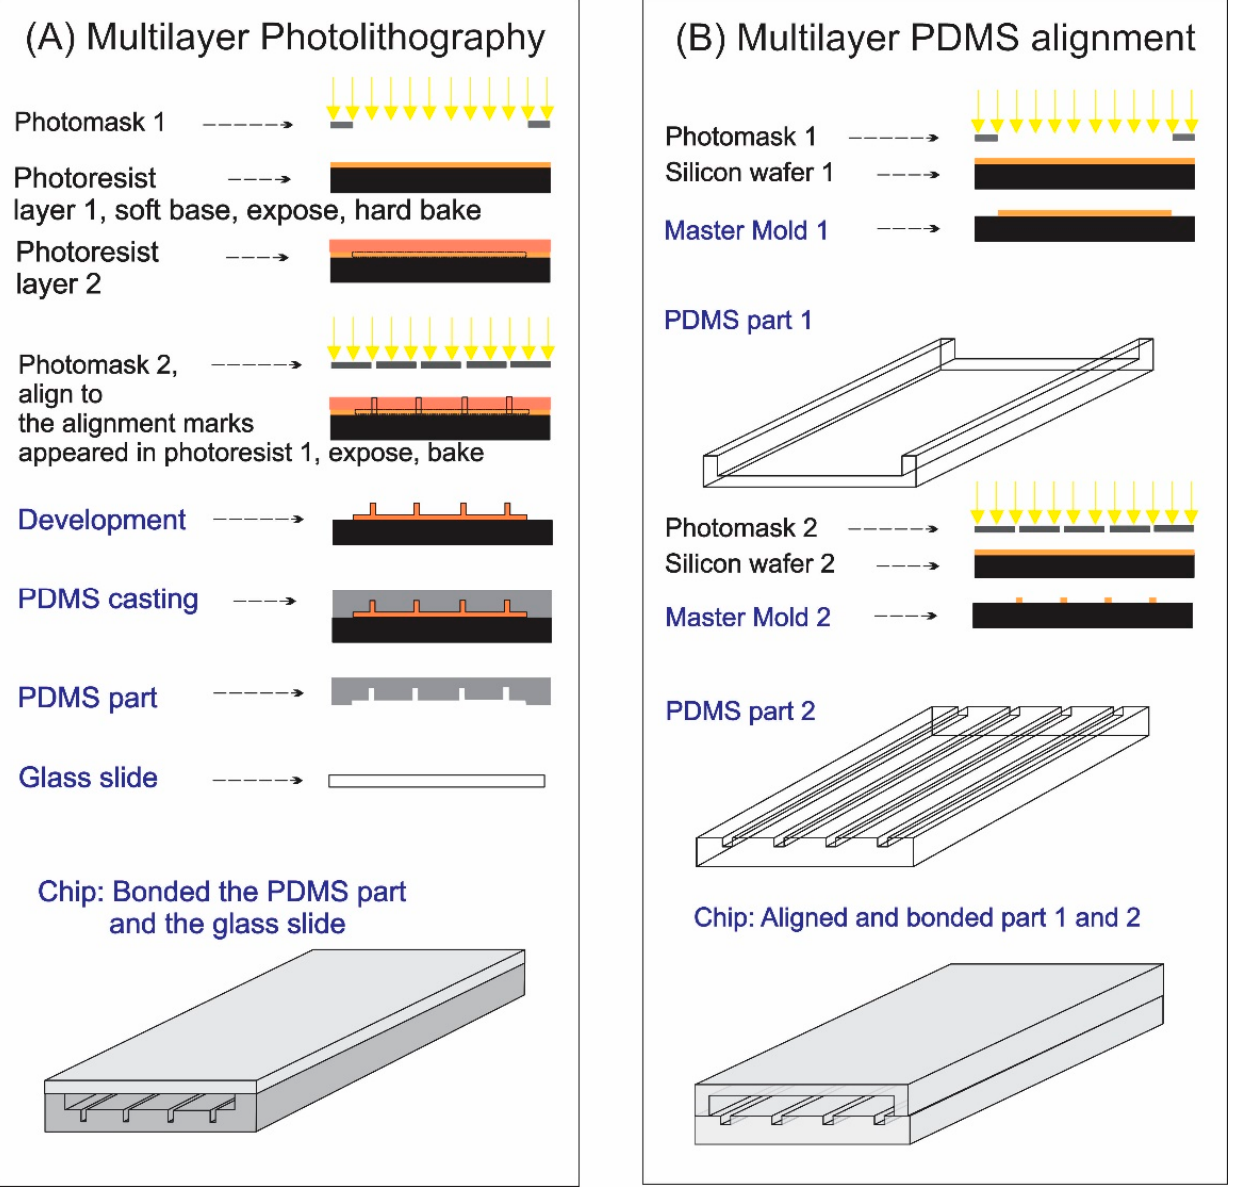
Figure 1. Schematics showing the process flows of fabricating: ( A ) the multilayer photolithography approach using a mask aligner to align the photomask number 2 to the marks on the previous exposure photoresist layer (created from photomask number 1); ( B ) a multilayer PDMS chip by alignment of two PDMS slabs. Both methods result in the same PDMS structures in the final chip. Figures were drawn by Dr. Nguyen.